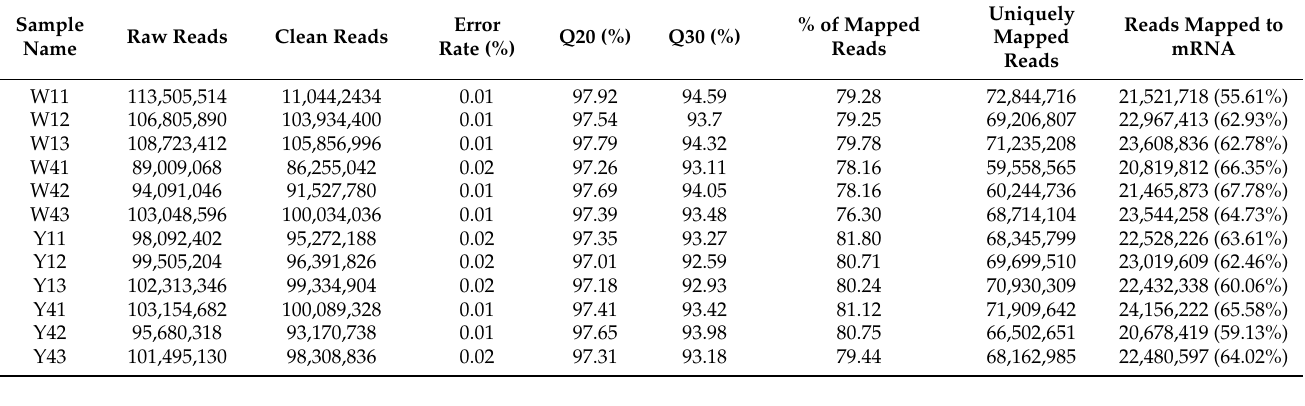
Table 1. Summary of reads filtering, mapping, and counting in RNA-seq.